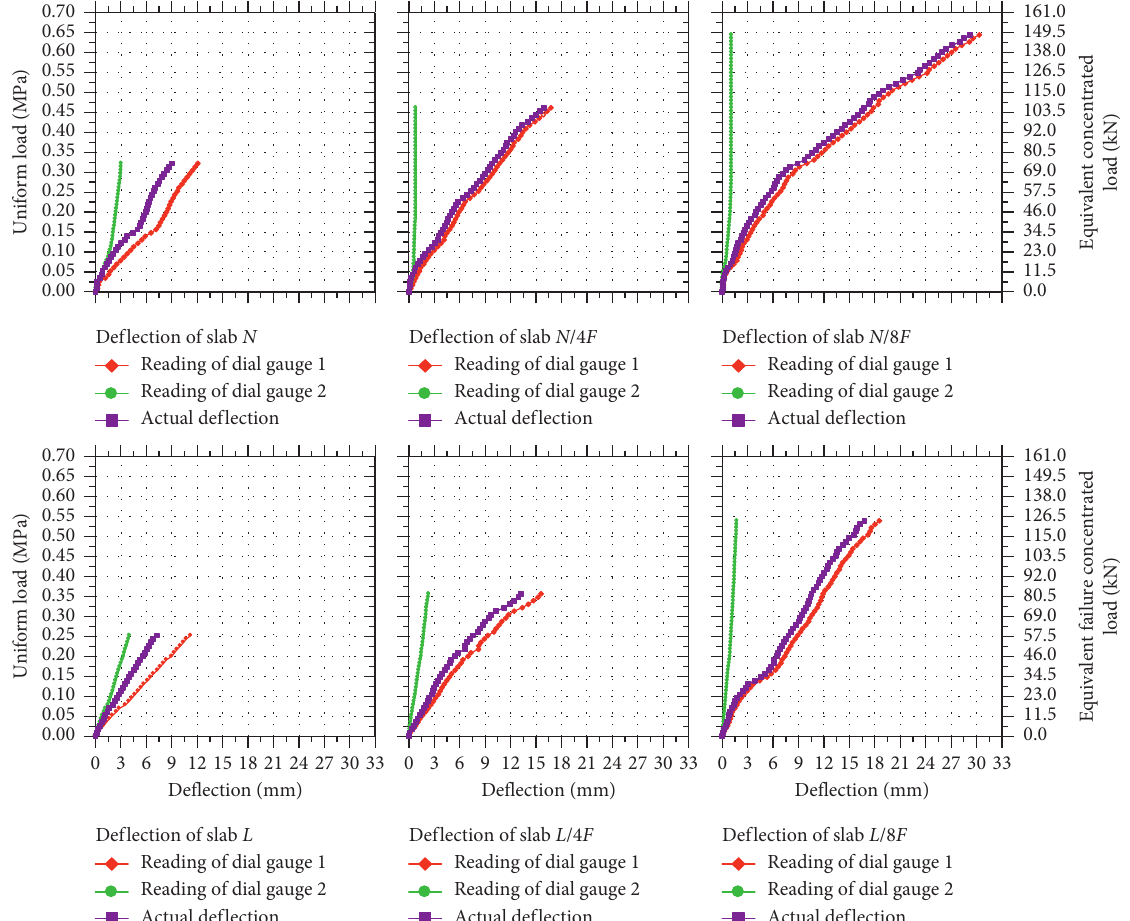
Figure 10: Load-deflection curves for the normal-weight concrete slabs ( N ), ( N /4 F ), and ( N /8 F ) and lightweight concrete slabs L , ( L /4 F ), and ( L /8 F